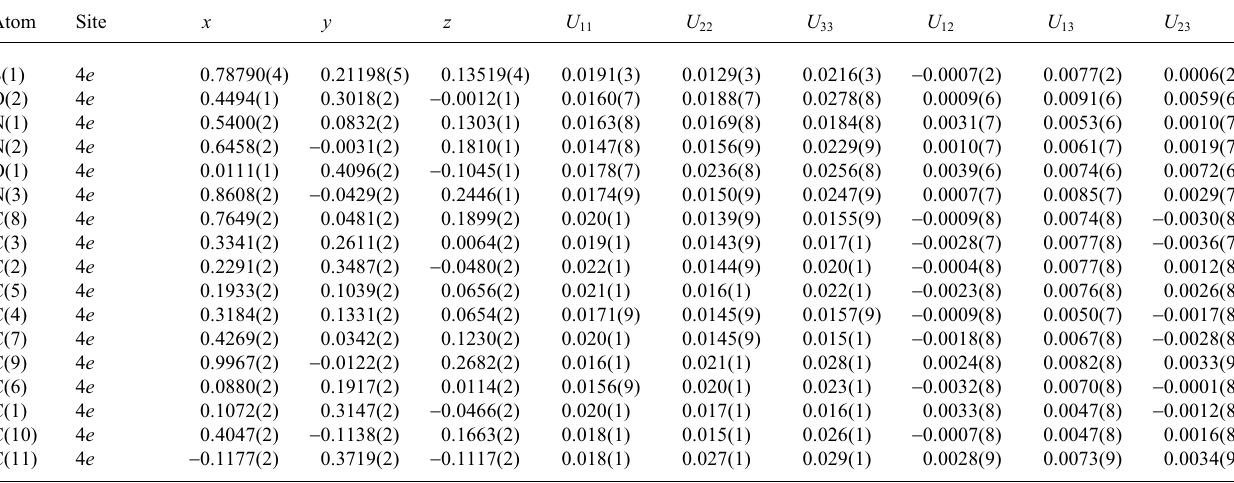
Table 3. Atomic coordinates and displacement parameters (in Å 2 )